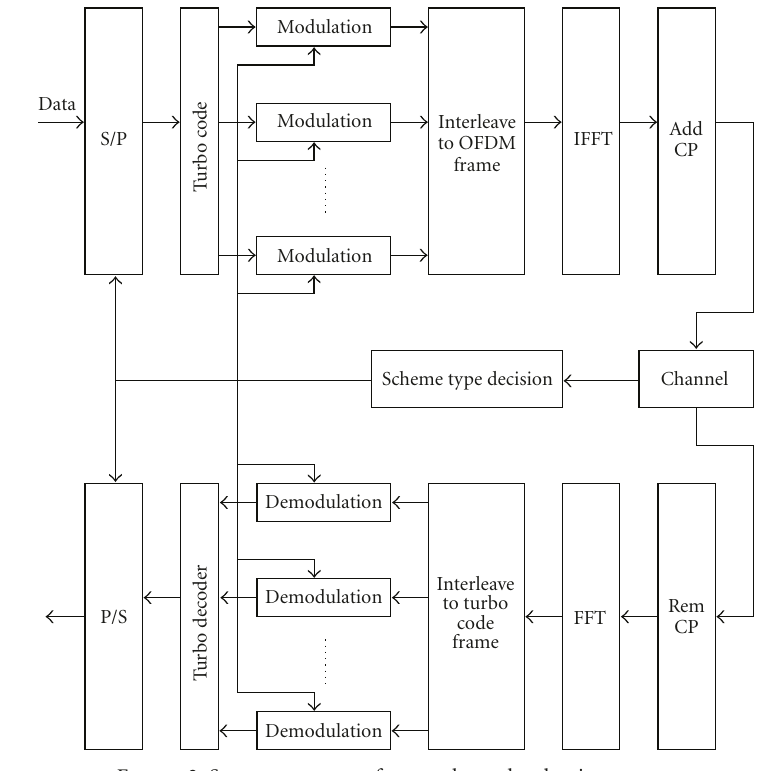
Figure 2: System structure of one turbo code adaptive system.